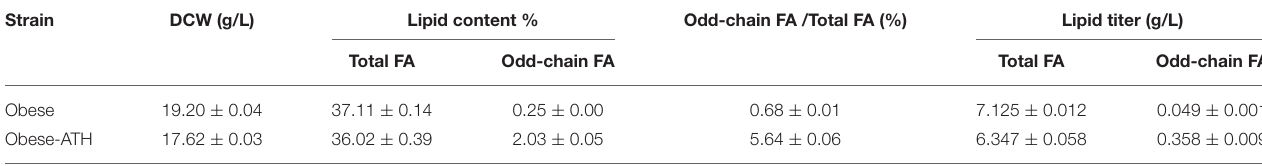
TABLE 4 | Comparison of the lipid profiles (% of each FA) of the WT-ATH strain and the obese-ATH strain. Strain C15:0